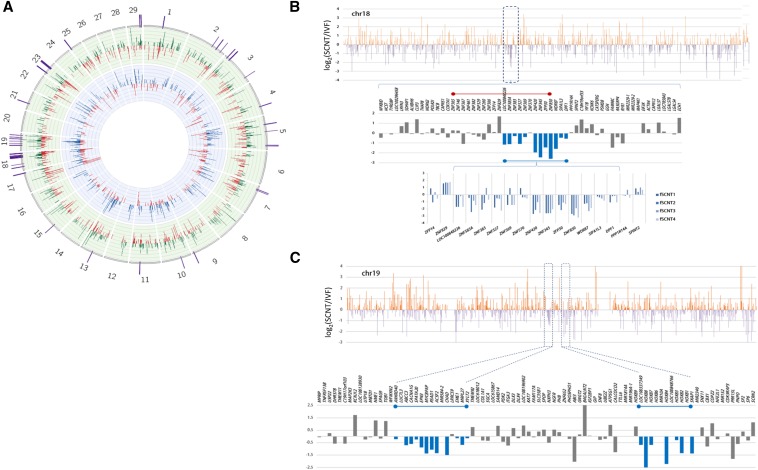
Representatives of coordinately regulated genomic regions in somatic cell nuclear transfer (SCNT) blastocysts. (A) Circos plot for differential expression profile (DEP). The inner circle on blue background represents DEP between cSCNT (blue bars) and in vitro fertilization (IVF; red) whereas the green circular layer indicates DEP between fSCNT (green bars) and IVF (red). Fold changes are between −5 and 5, and only significant differentially expressed genes (DEGs) (P-value < 0.05) are included in the plot. DEG-dense regions are depicted as purple bars on the plot surface. (B−C) Plots of DEGs in fSCNT blastocysts in chromosomes 18 (B) and 19 (C). All genes in chr18 are sorted in the order of the genomic location, and their fold-change values [log2(fSCNT/IVF)] were shown in the bar graph. Upper orange and lower purple bars indicate up- and down-regulation, respectively. Some representative genomic regions that seem to be under coordinate regulation are boxed and enlarged below and, in these regions, coordinately regulated genes are indicated in blue.